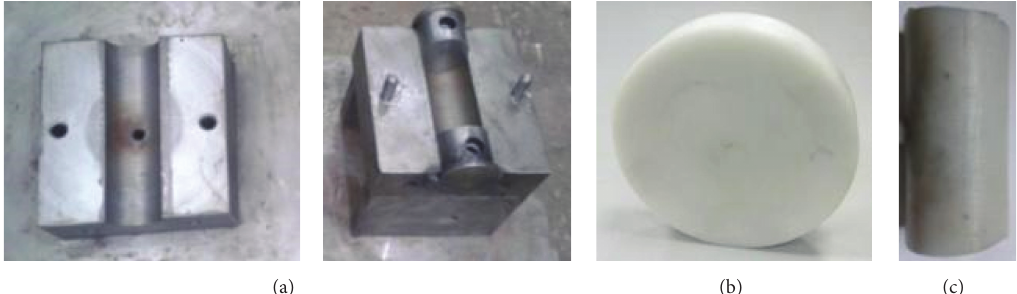
Figure 1: Injection die and products. (a) Photograph view of short-rod injection die. (b) Product acetal flange. (c) Product acetal short rods.